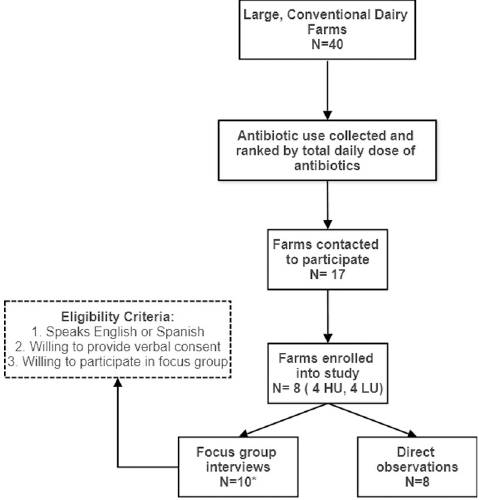
Fig 2. Flowchart of study enrollment. HU = high use farms; LU = Low use farms. � Two separate focus groups were conducted on two of the